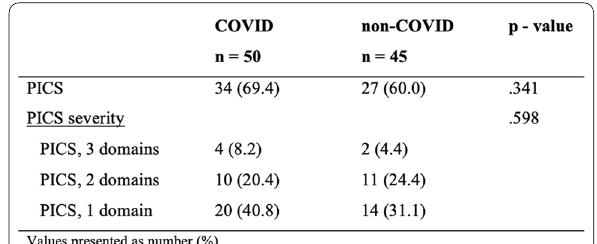
Figure 2. Frequency of Post Intensive Care Syndrome (PICS) and its severity by affected domains tested by Pearson’s chi-squared test.